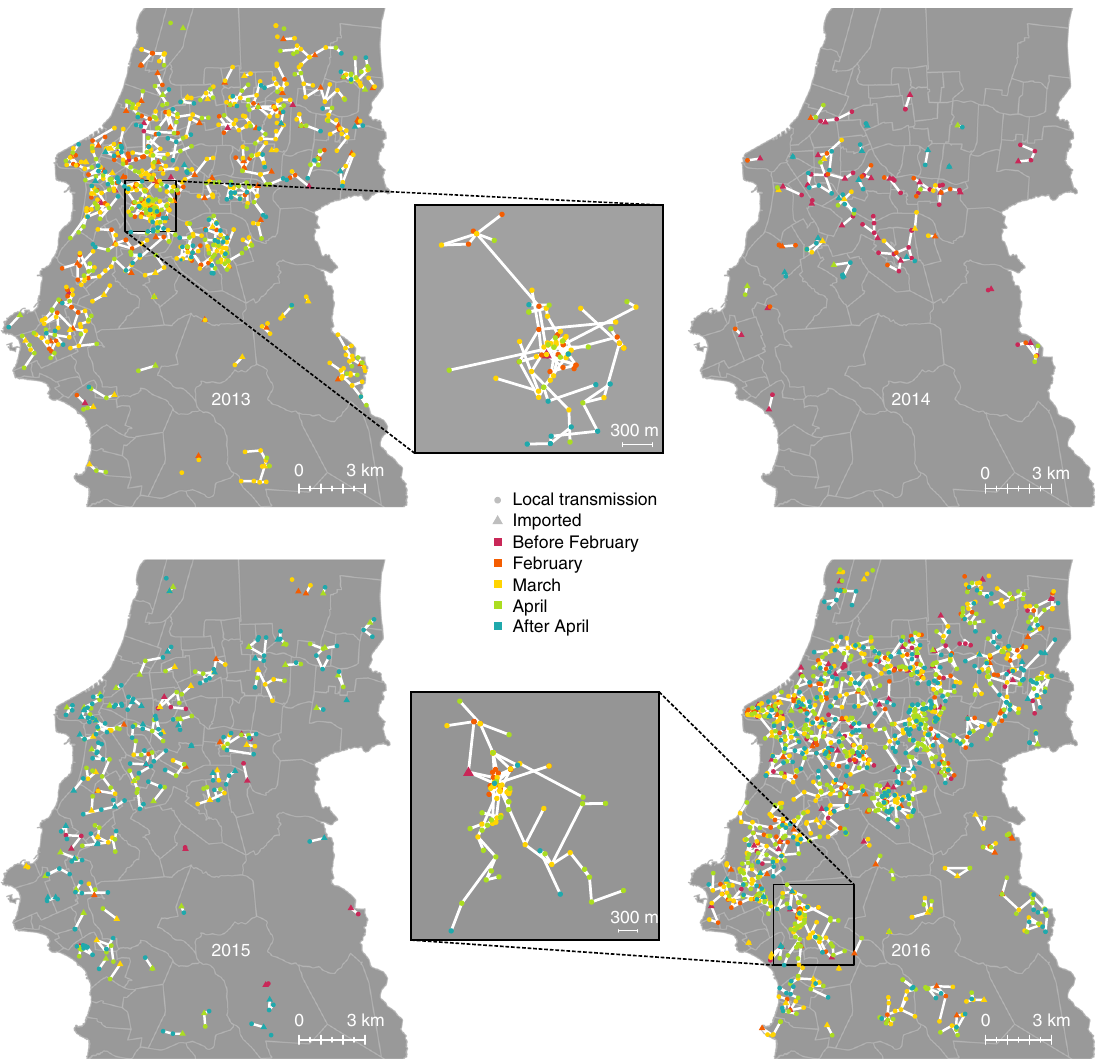
Fig. 1 Spatio-temporal transmission chains. Maximum likelihood transmission chains occurring in Porto Alegre over the four years of study, with a detail on the two largest clusters. Triangles represent imported cases and circles represent locally transmitted cases. Different colors are used to show the time of symptom onset. White lines indicate a transmission link between cases; light gray boundaries indicate borders between administrative